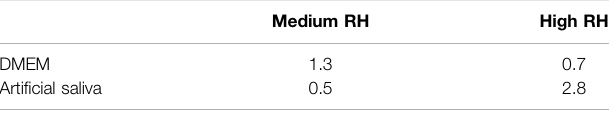
TABLE 1 | Half-life of aerosolised SARS-CoV-2 under different conditions – data from Smither et al.,